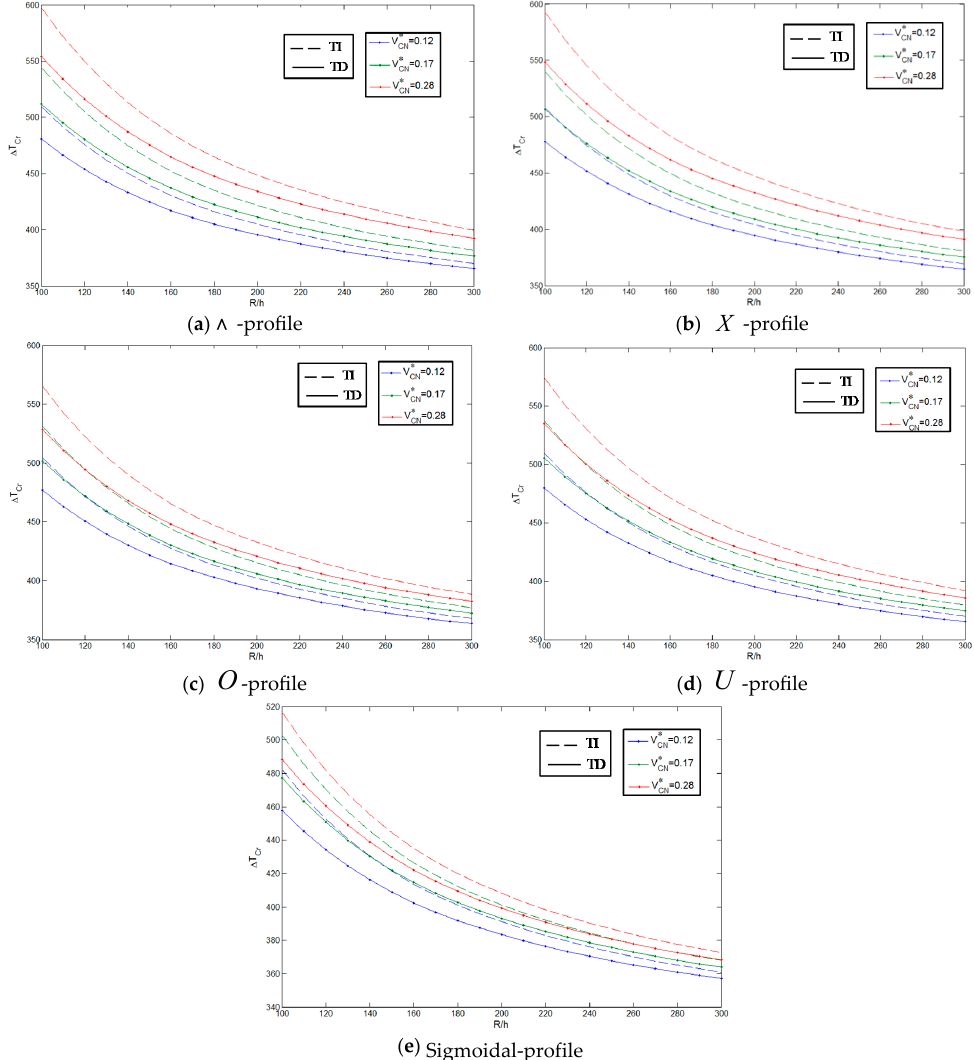
V  CNT considering L / R = 2, A R = 500, w = 0.425, CNT